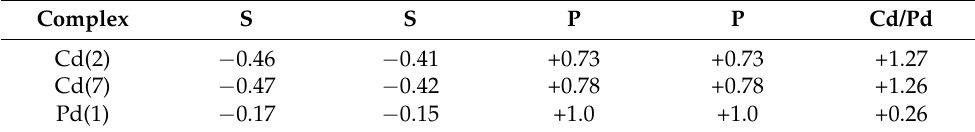
Table 4. NBO charges for the central ion and the connected atoms.